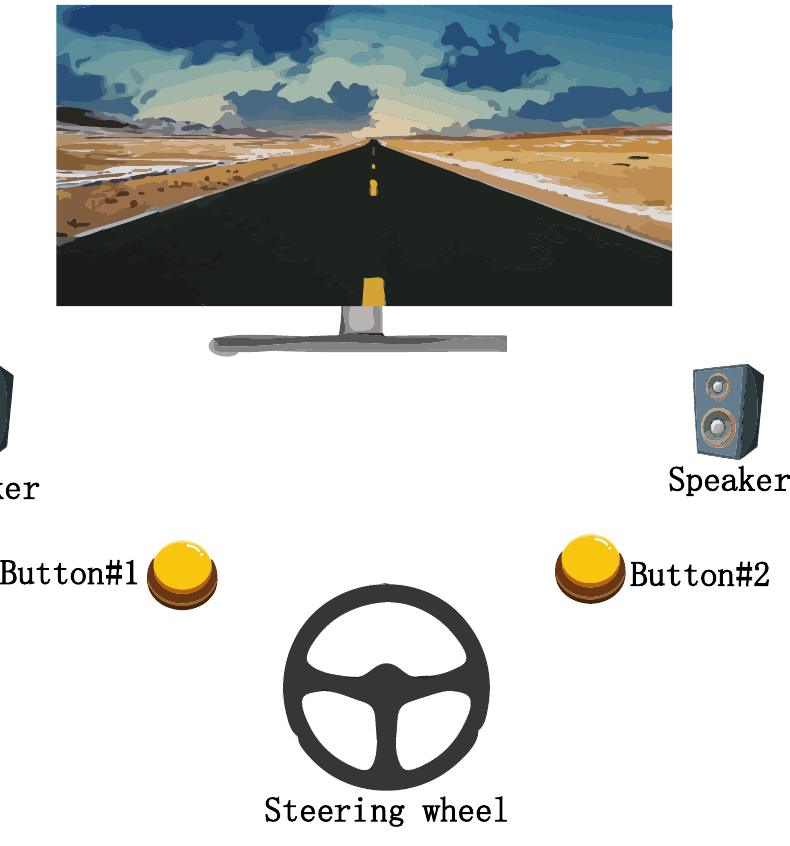
Figure 1. Experimental settings.